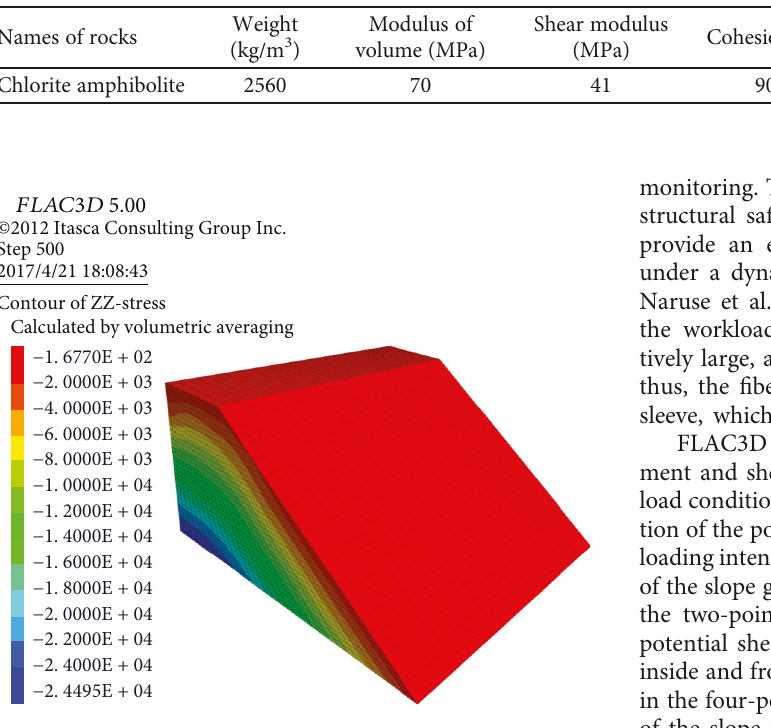
Figure 19: Results of the of elastic stress fi eld